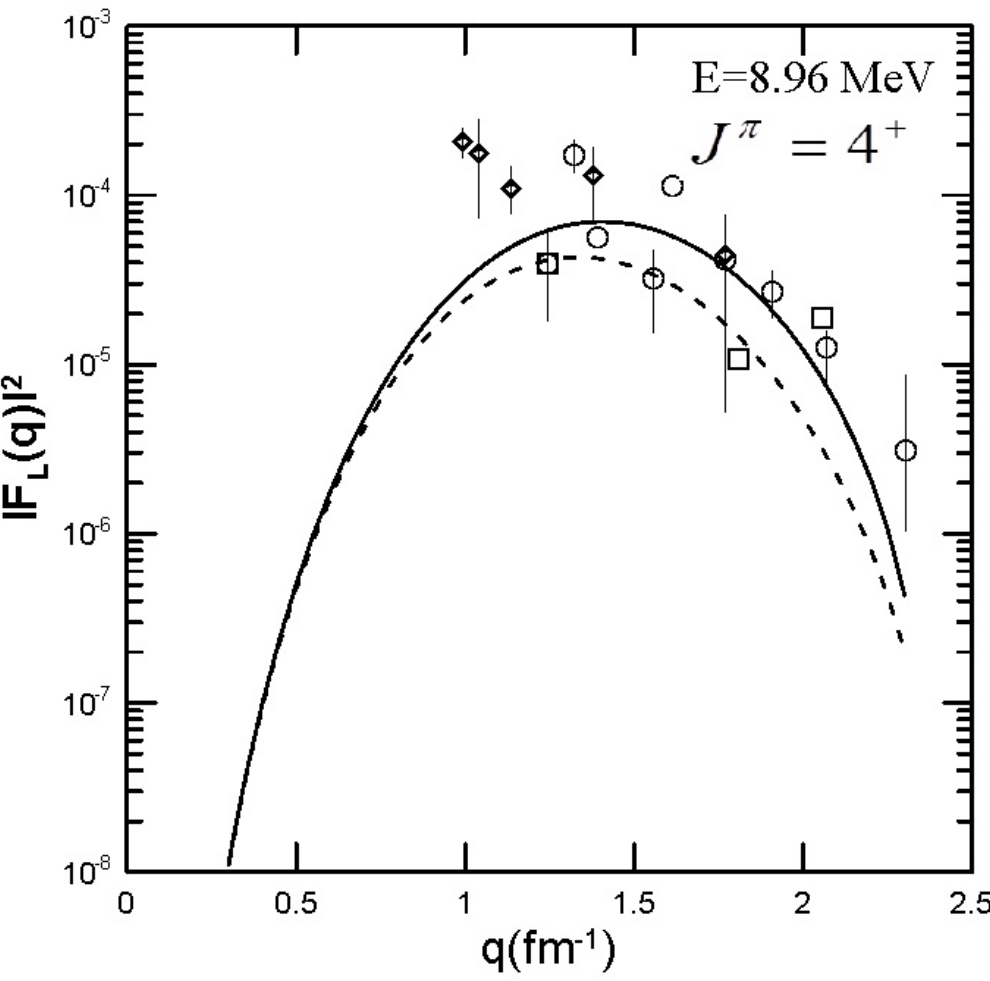
Fig. 3: Inelastic Coulomb 4 C form factors for the transition to the 14  (8.96 MeV) state. The dashed and solid curves are the calculated 4 C form factors without and with the inclusion of the effect of the SRC, respectively. The open circle, open square and rhomb symbols are those of the experimental data taken from ref.